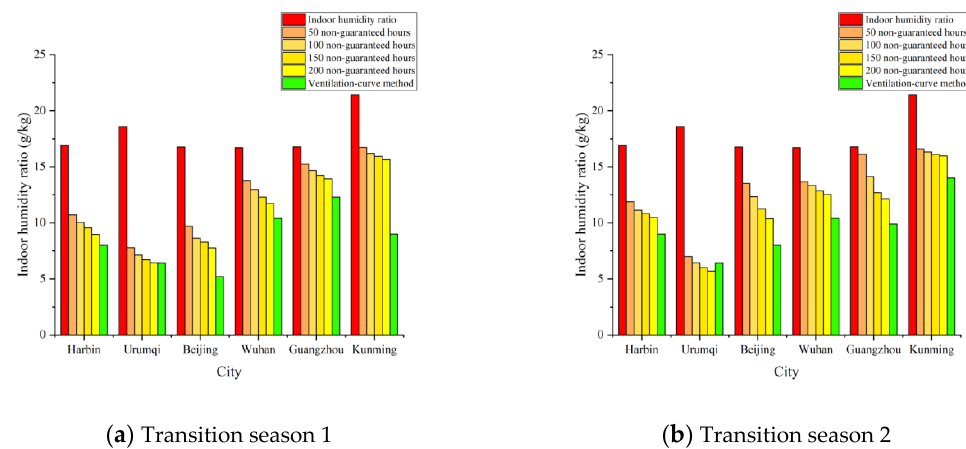
Figure 6. Calculation of indoor and outdoor humidity ratios.